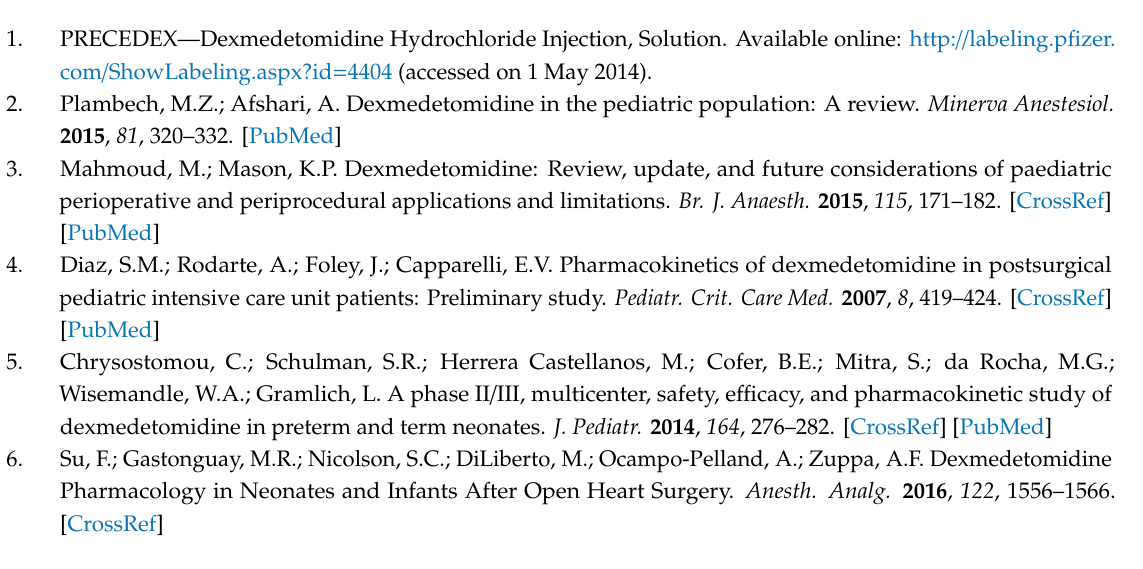
Table S1: Overview of previously published pharmacokinetic estimates of dexmedetomidine in the pediatric population, standardized for a body weight of 70 kg using the allometric